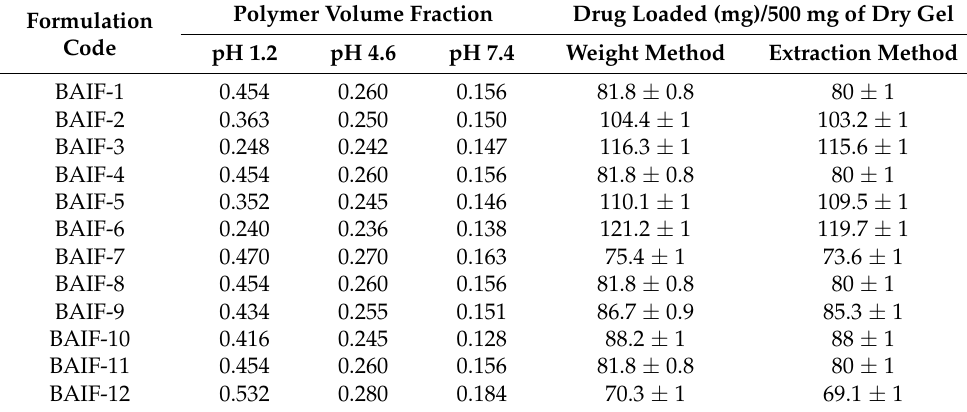
Table 2. Polymer volume fraction and drug loading of β -CD- g -P(Aa/Ia) hydrogels. Polymer Volume Formulation Code